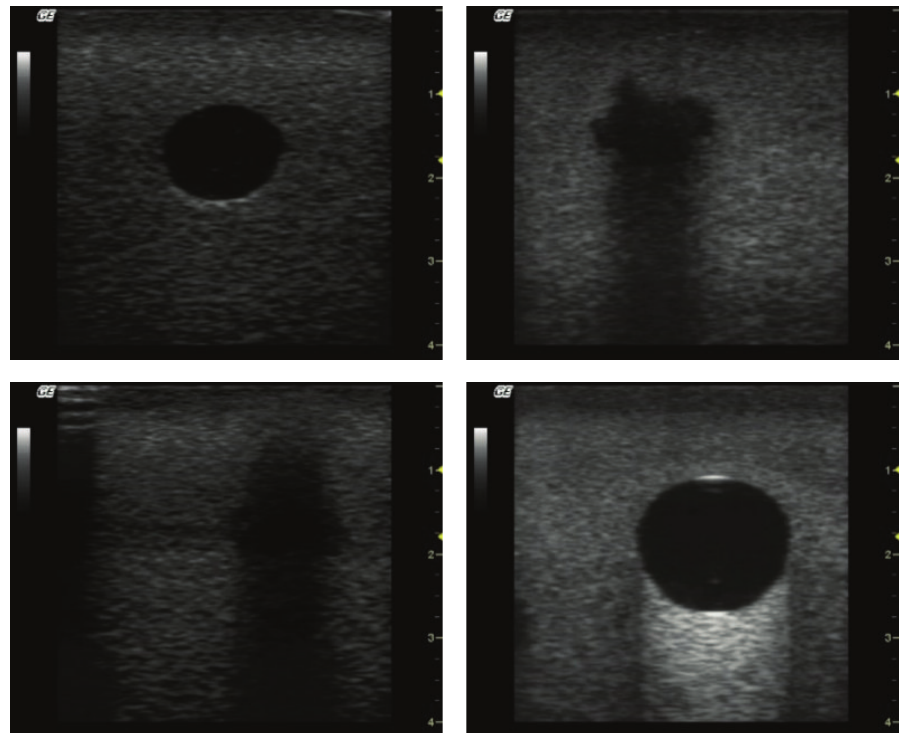
Figure 2: Ultrasound images obtained from exposures of the phantoms shown in Figure 1.